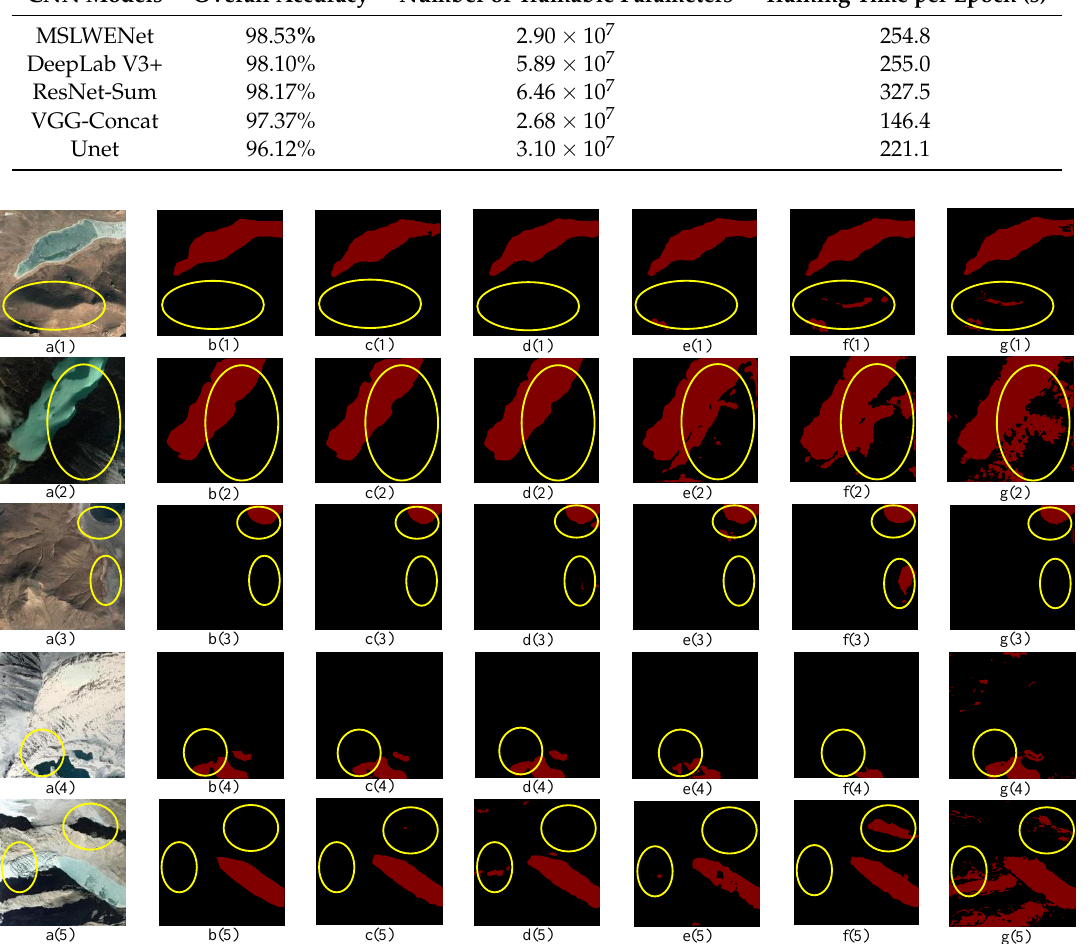
Figure 10. Performance comparison of different encoders and decoders. ( a(1) – a(5) ) are the raw images in the test set; ( b(1) – b(5) ) are the ground truths to which the raw images correspond; ( c(1) – c(5) ), ( d(1) – d(5) ), ( e(1) – e(5) ), ( f(1) – f(5) ), and ( g(1) – g(5) ) are the extracted results of MSLWENet, DeepLab V3+, ResNet-Sum, VGG-Concat, and Unet,